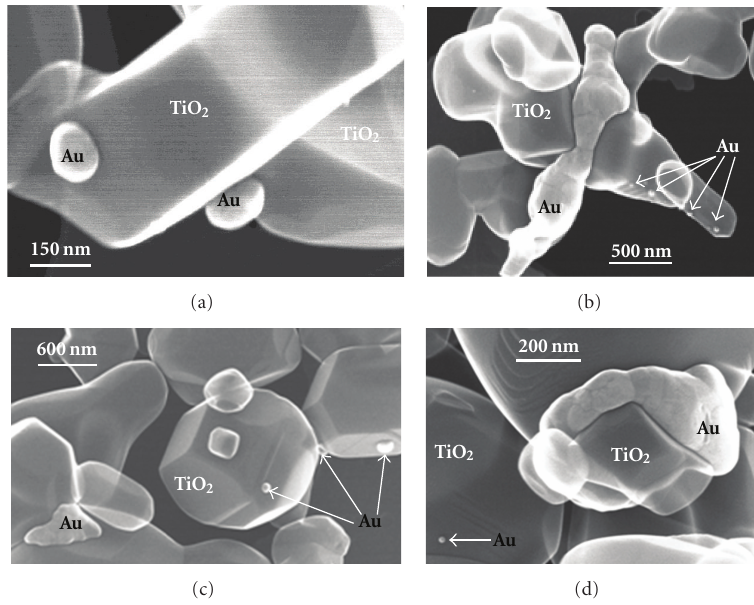
Figure 10: STEM images of Au/TiO 2 : Aldrich R (10wt% Au).